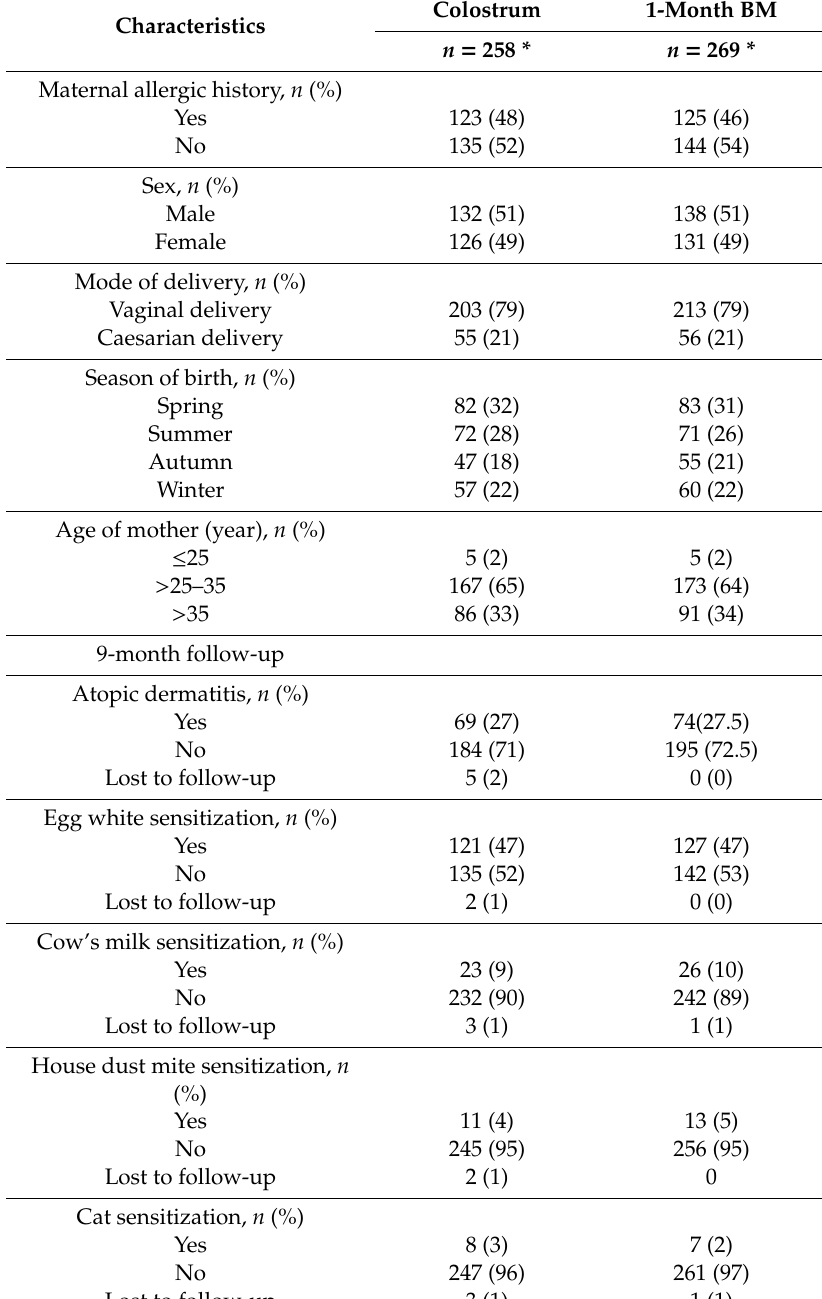
Table 1. Characteristics of colostrum and 1-month BM